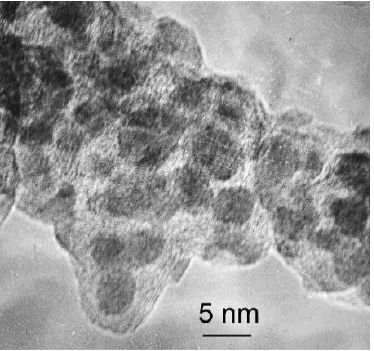
Figure 1. TEM image of Fe@C nanoparticles.